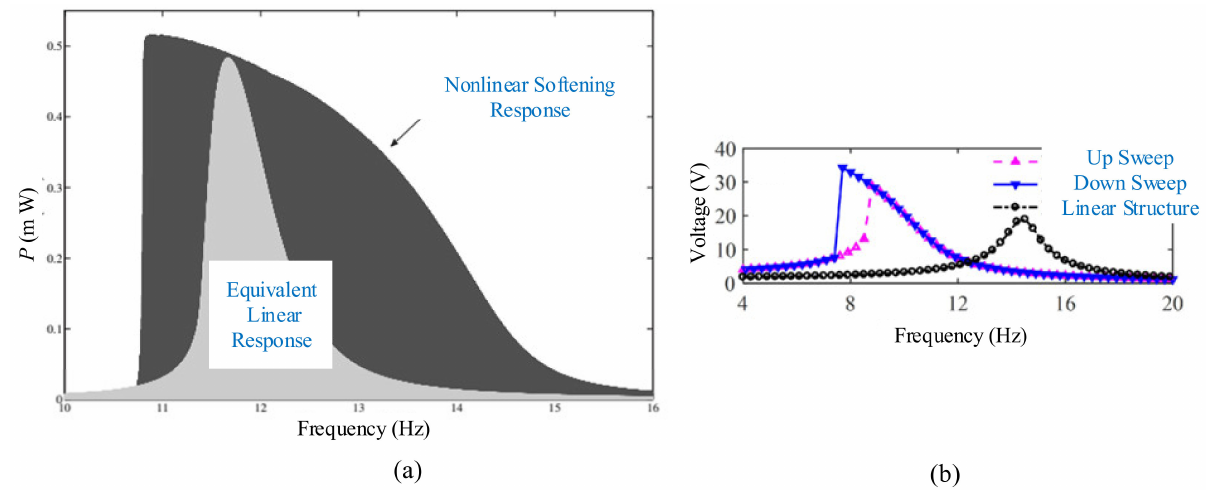
Figure 4. Nonlinear and linear energy-harvest responses. ( a ) The research results by Stanton et al. (reproduced with permission from [122]; published by American Institute of Physics, 2009). ( b ) The research results by Fan et al. (reproduced with permission from [125]; published by AIP,